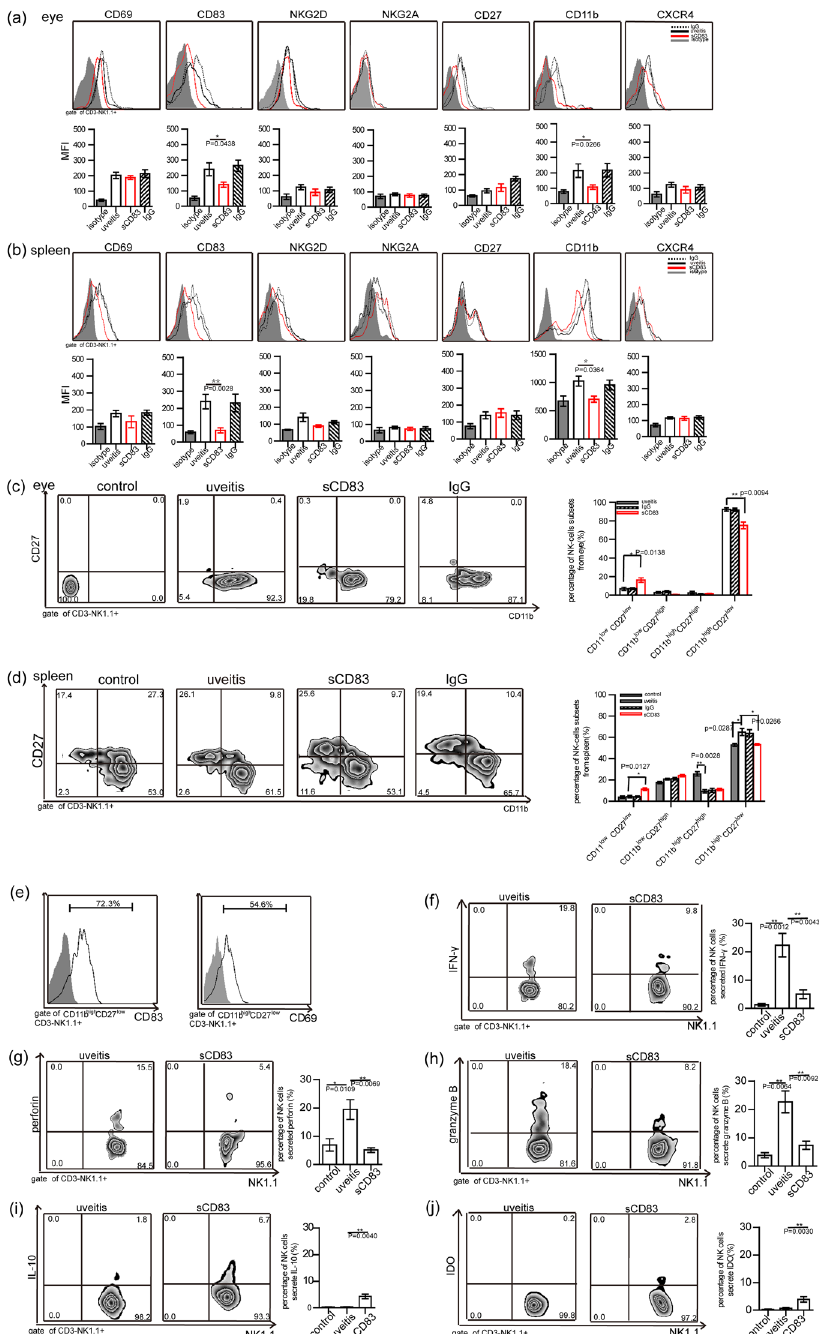
Figure 3. Phenotype and function of NK cells within the eyes or spleen of EAU mice treated with sCD83 as analyzed using flow cytometry. Expressions of CD69, CD83, NKG2D, NKG2A, CD11b, CD27 and CXCR4 in infiltrating CD3 − NK1.1 + cells from inflamed eyes ( a ) or spleen ( b ) of EAU mice treated with sCD83 as analyzed by flow cytometry. The MFI of these molecules were analyzed and compared with NK cells obtained from inflamed eyes of EAU mice without sCD83 treatment. IgG treatment was used as a negative control. ( c , d ) Subsets of CD3 − NK1.1 + cells infiltrating into inflamed eyes (left panel of Fig. c, a representative result from three experiments) or spleen (left panel of Fig. d, a representative result from three experiments) in EAU mice with or without sCD83 treatment. Percent of CD11b high CD27 low CD83 + CD3 − NK1.1 + NK-cell subsets in inflamed eyes or spleen was compared with that of sCD83 treated mice (the right bar-graph of Fig. c and d; A total of ten mice/group were used and experiments were replicated three times, mean ± s.e.m. * P < 0.05, ** P < 0.01). IgG treatment was used as a negative control. ( e ) Expressions of CD69 and CD83 in CD11b high CD27 low CD3 − NK1.1 + NK-cells were analyzed using flow cytometry. ( f – j ) Percent of NK cells secreting IFN- γ , perforin, granzyme B, IL-10 or IDO in response to sCD83 treatment, (a total of ten mice were used and the experiment was replicated three times, values represent the mean ± s.e.m., * P < 0.05, ** P <